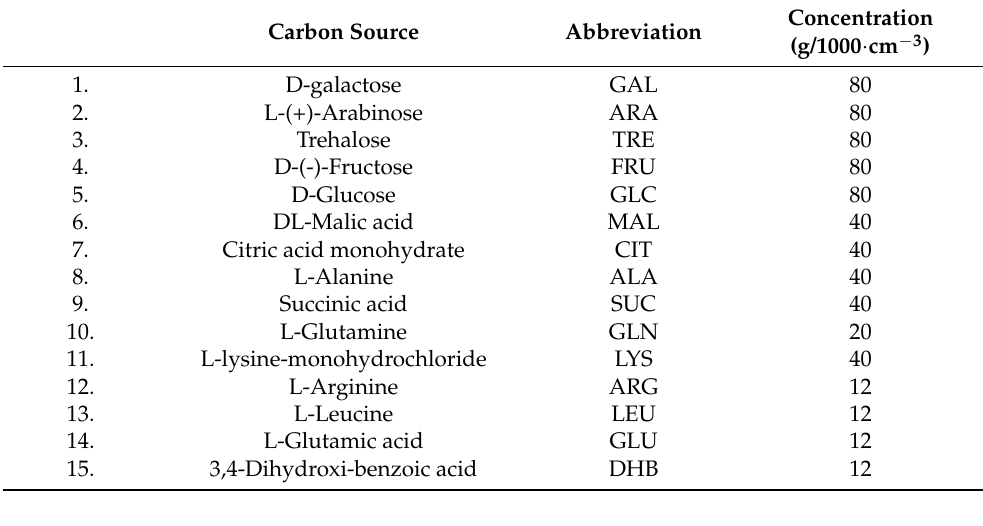
Table 1. Organic carbon sources and their concentrations applied to evaluate microbe communities in the salt-affected soil of Apajpuszta, Hungary.